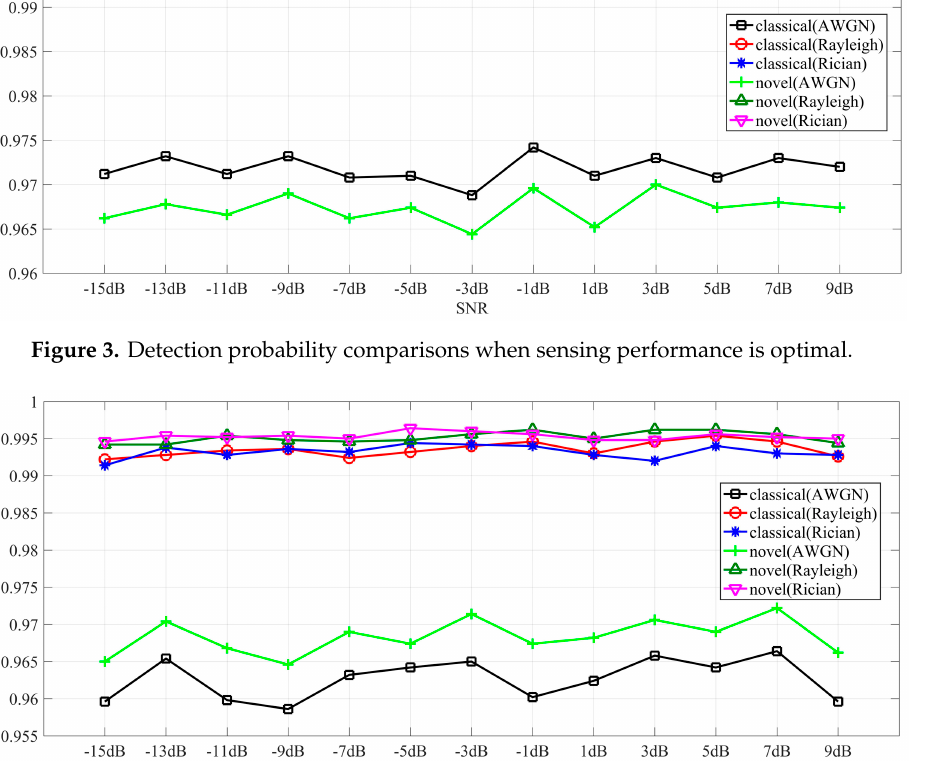
Figure 3. Detection probability comparisons when sensing performance is optimal.